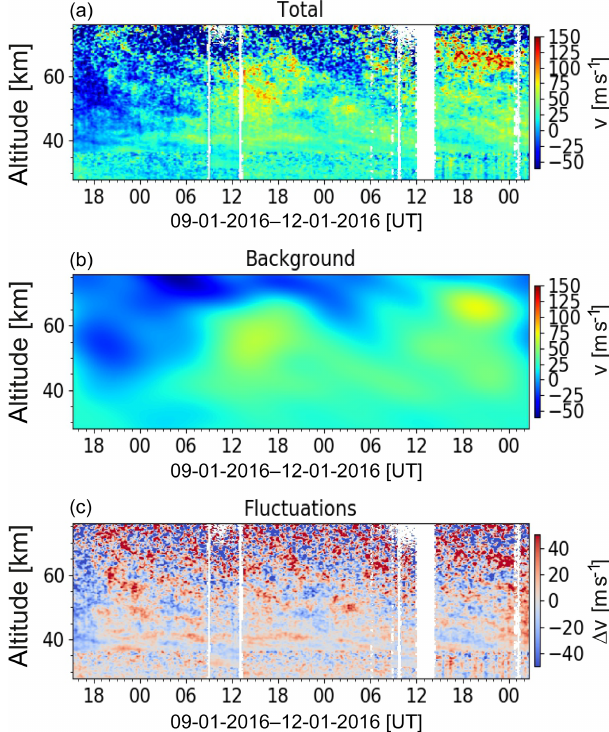
Figure 3. The same as Fig. 2 but for zonal wind observations.